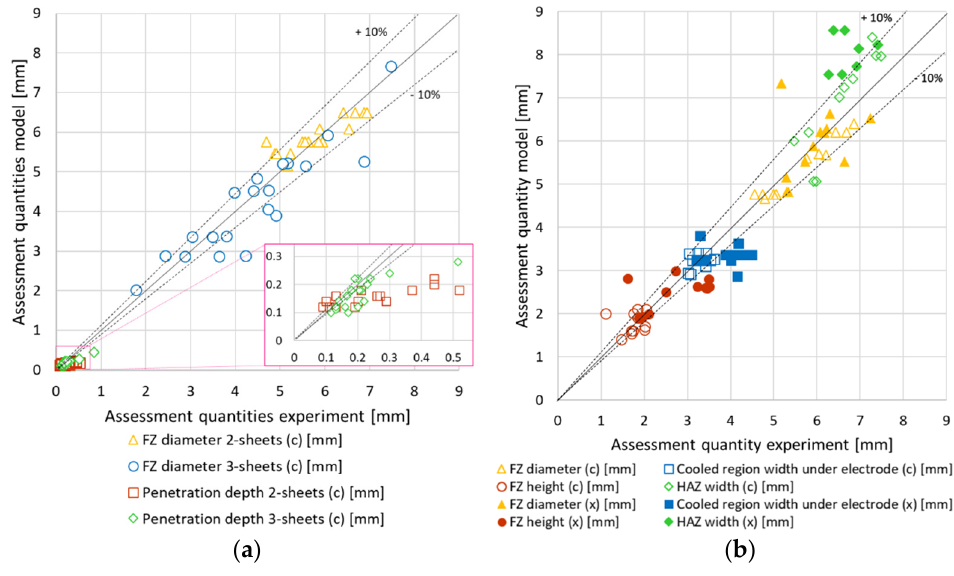
Figure 8. Comparison of the model and experiments for ( a ) burst opened and ( b ) micrographs while (c) marks welds done with the C-calliper and (x) marks welds with the X-calliper.